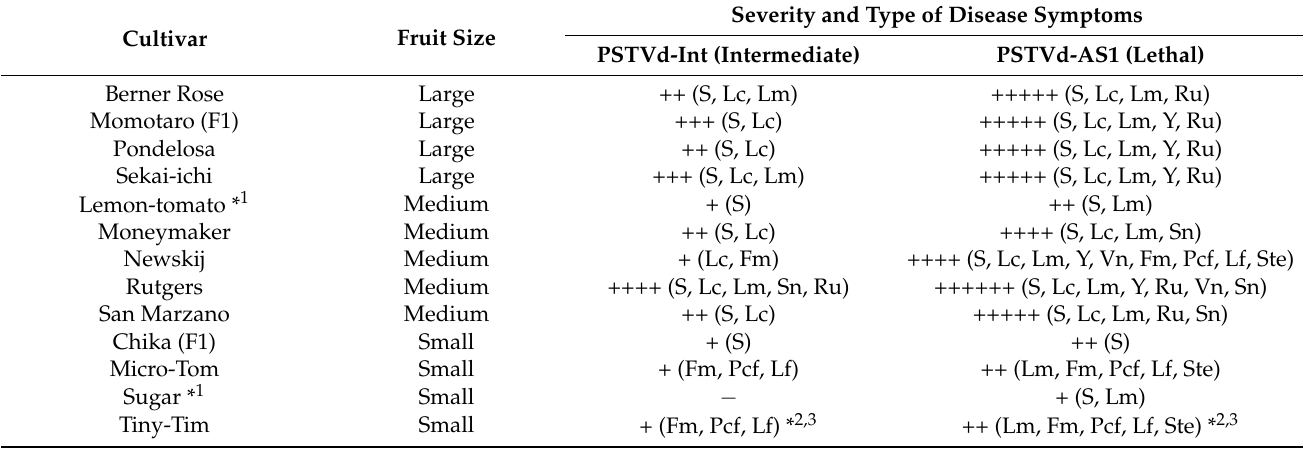
Table 1. Symptoms of tomato cultivars infected with intermediate and lethal strains of PSTVd. Severity and Type of Disease Symptoms Cultivar Fruit Size PSTVd-Int (Intermediate)